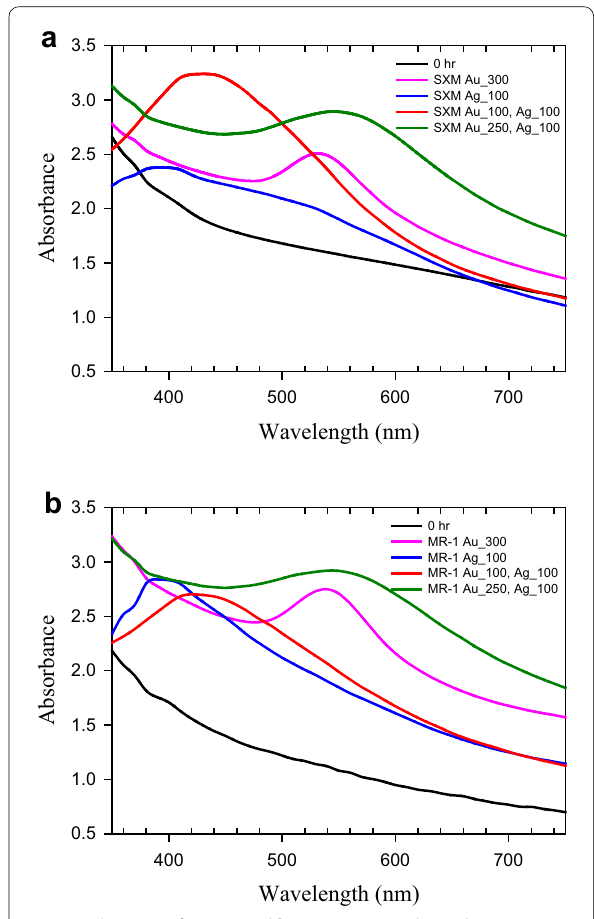
Fig. 6 Selectivity of a SXM and b MR‑1 immersed in only 300 ppm Au 3 + (pink), only 100 ppm Ag + (blue), 100 ppm Au 3 + mixed with 100 ppm Ag + (red), or 250 ppm Au 3 + mixed with 100 ppm Ag +